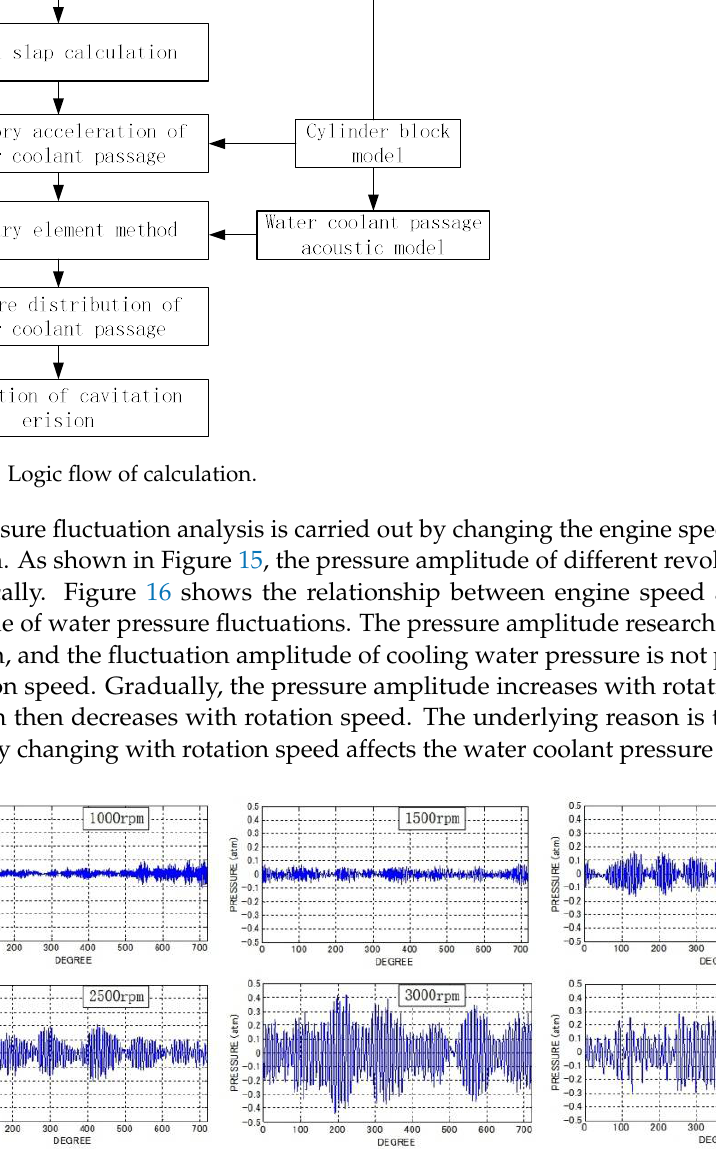
Figure 16. Maximum amplitude of water pressure changing with engine rotation speed. In order to find the key factors influencing coolant pressure fluctuation, we examine the spectrum of liner acceleration and pressure closely at 3000 rpm. As shown in Figure 17, large frequency components of the liner acceleration spectrum are found around 800 Hz, 1600 Hz and from 2100 to 2700 Hz with nearly the same magnitude. The frequency peaks of the pressure spectrum are similar to the vibration spectrum. However, the component around 2200 Hz stands out and it is nearly 10 times greater than other peaks. The peak frequency of 2200 Hz roughly dominates the amplitude of the time waveform of coolant fluctuating pressure. Such a prominent frequency component is considered to be affected by the acoustic characteristics of the cooling water chamber. Figure 17. Liner acceleration and coolant pressure spectrum at the revolution speed of 3000 rpm. As mentioned in the previous section, the cooling water chamber has an acoustic resonance point at 2217 Hz, which corresponds to the resonant mode in the left and right